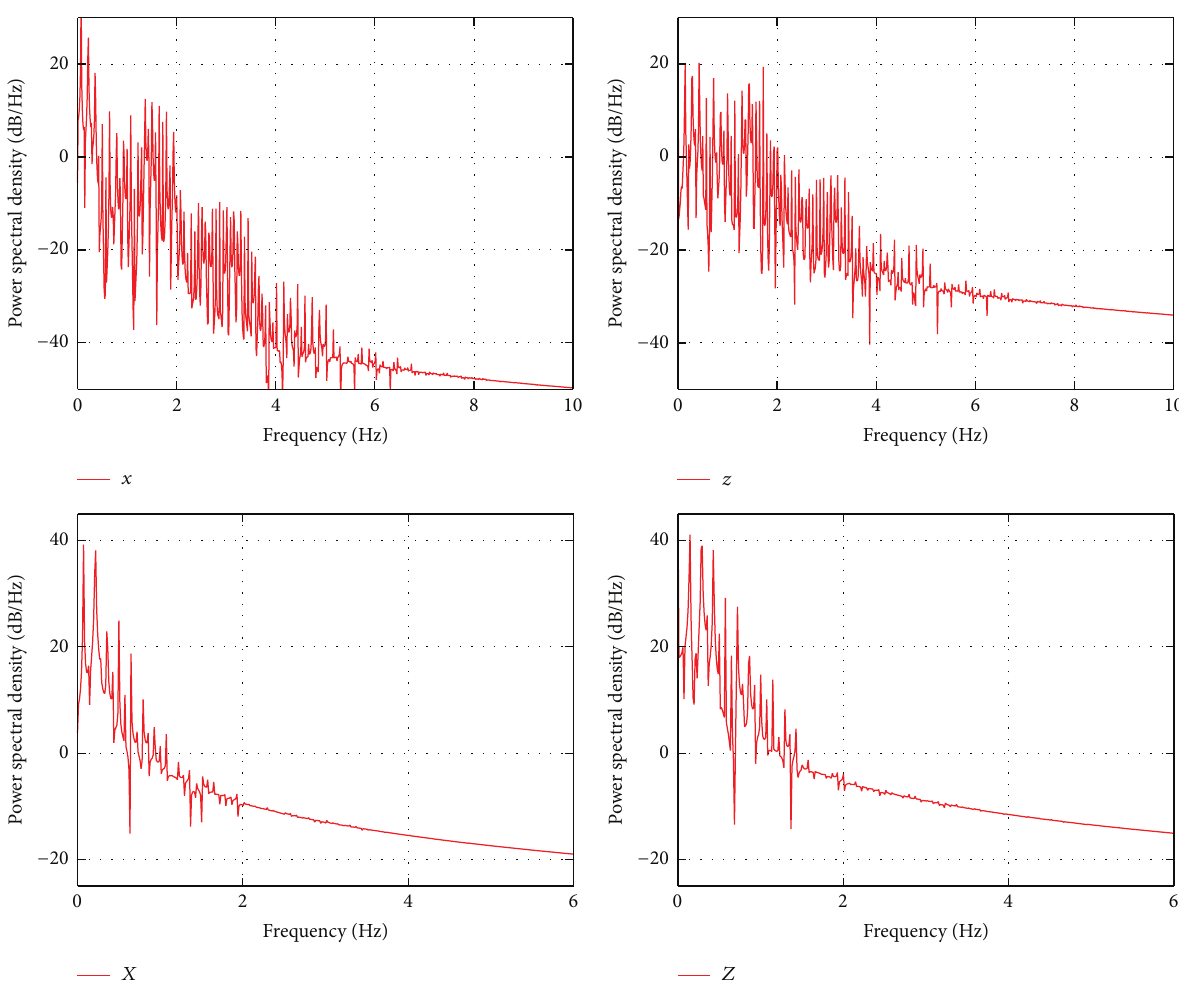
Figure 9: Power spectral density estimate of fast ( 𝑥 and 𝑧 ) and slow ( 𝑋 and 𝑍 ) dynamic variables for 𝑐 = 0.8 .